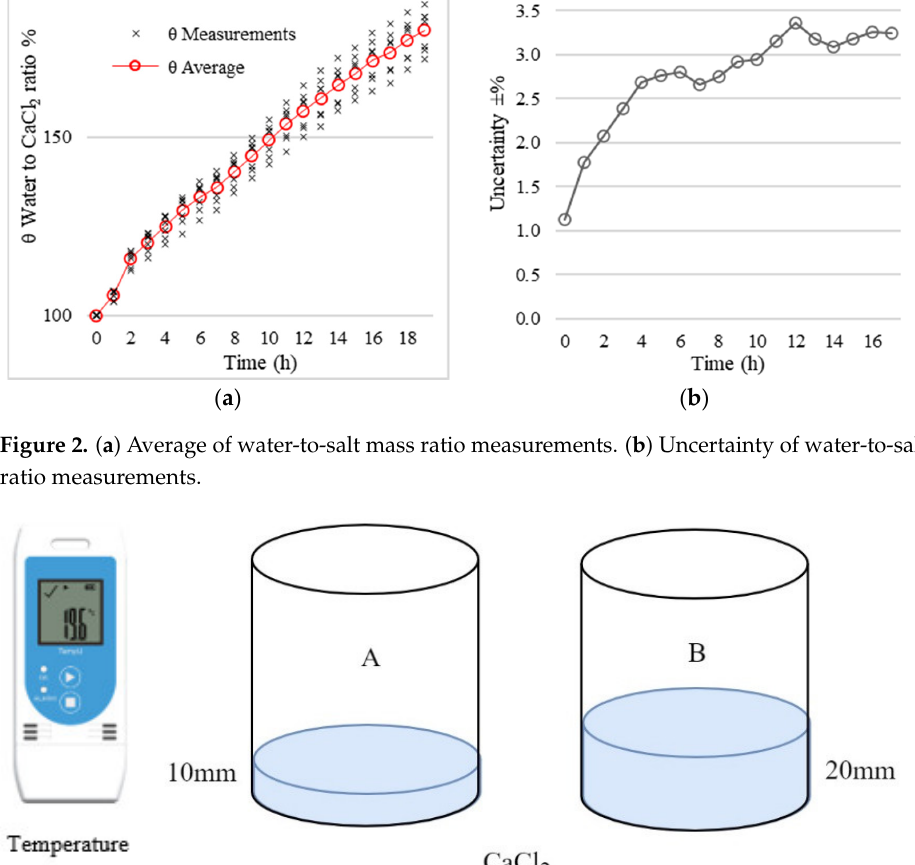
Figure 2. ( a ) Average of water-to-salt mass ratio measurements. ( b ) Uncertainty of water-to-salt mass ratio measurements.